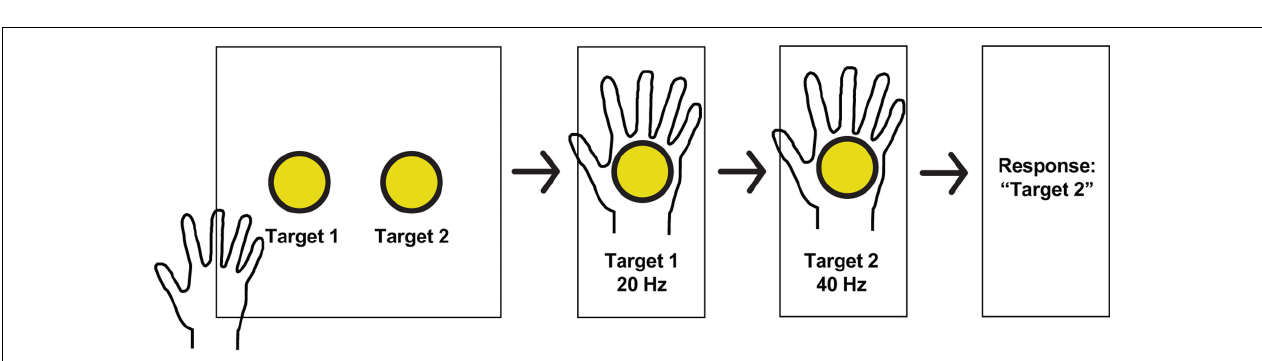
FIGURE 1 | Electrocorticography grid placement. (A) 3-dimensional images of each subject’s brain from a magnetic resonance image, with the location of the electrodes superimposed. The central sulcus is outlined in purple and electrodes of the grid are shown in red. The electrodes chosen for stimulation in this experimental model are highlighted in yellow. S12 had electrodes with 1 cm of spacing, and S18 and S30 had electrodes with 3 mm of spacing (center-to-center). (B) The dermatomal distribution of the percepts used for testing after grid mapping for each subject.